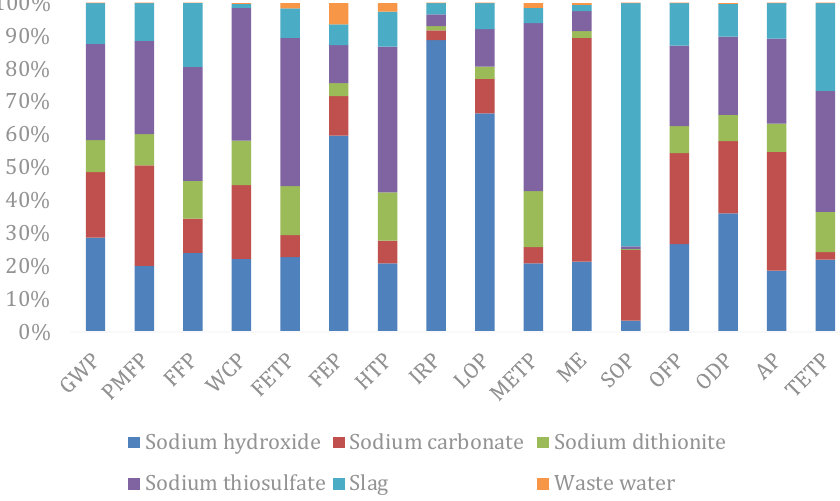
Figure 5. Subdivided end-point indicators of the input–output items of the silver separation pro-